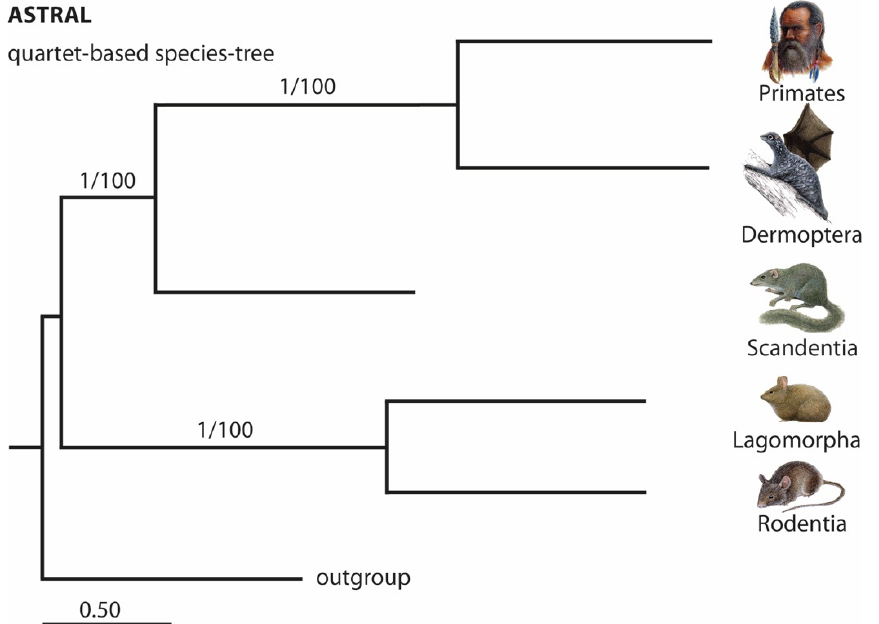
Figure 4. ASTRAL_BP quartet-based species tree for the 361 retrotransposon markers. Branch labels are posterior probabilities and bootstrap values, respectively. Branch lengths in coalescent units are indicated by a scale bar.